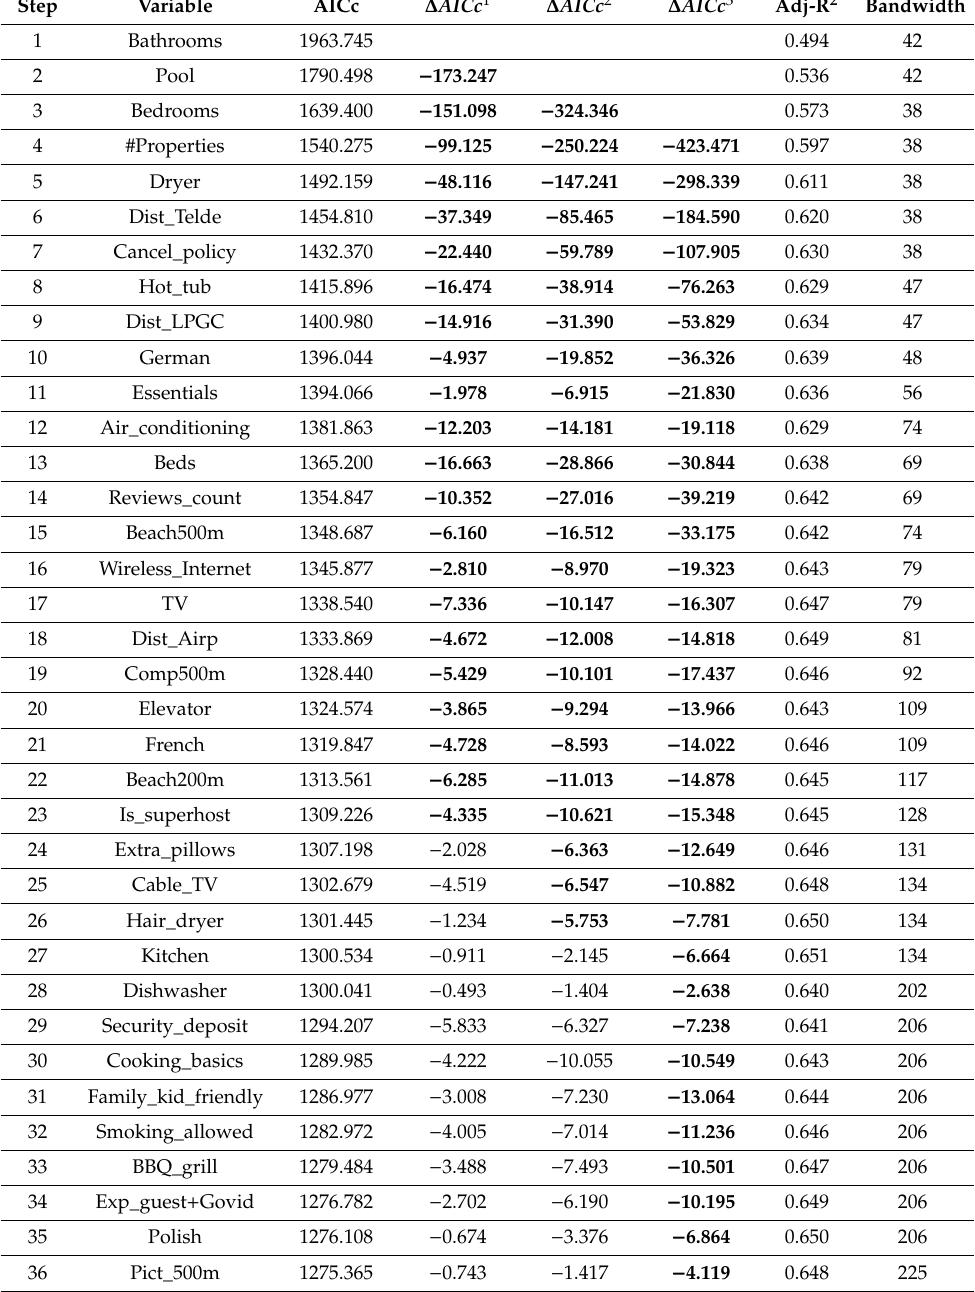
Table 1. Pre-SW-GWR step-by-step